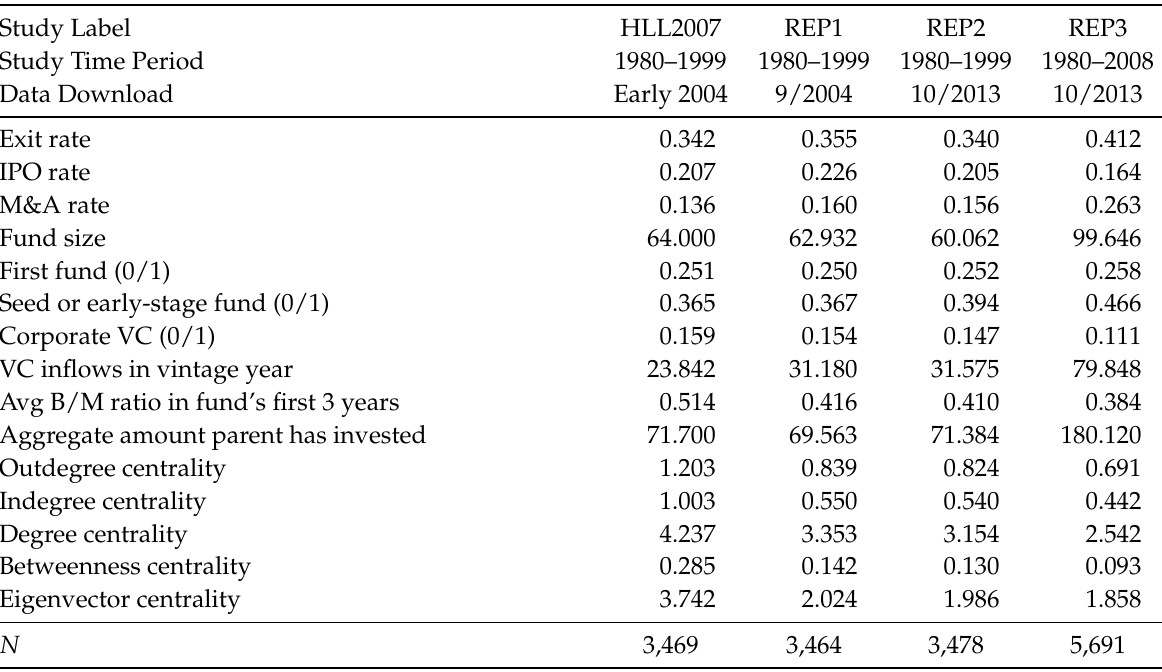
Table 1: Fund-level variable means for HLL2007 and three replication